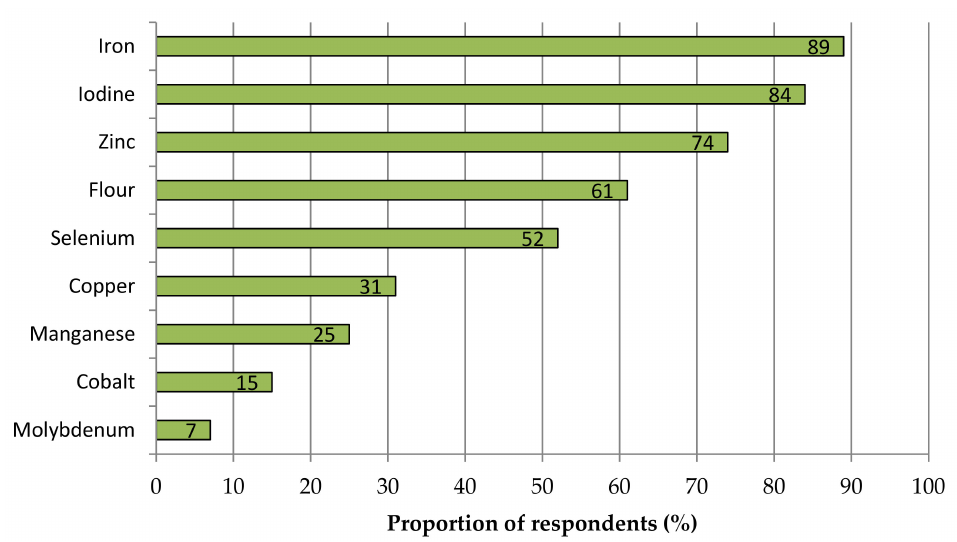
Figure A1. Consumer responses on the awareness of trace elements in the context of nutrition. n = 1016. Table A1. Respondents’ assessment of the effect of iodine on the human body. n = 1016.